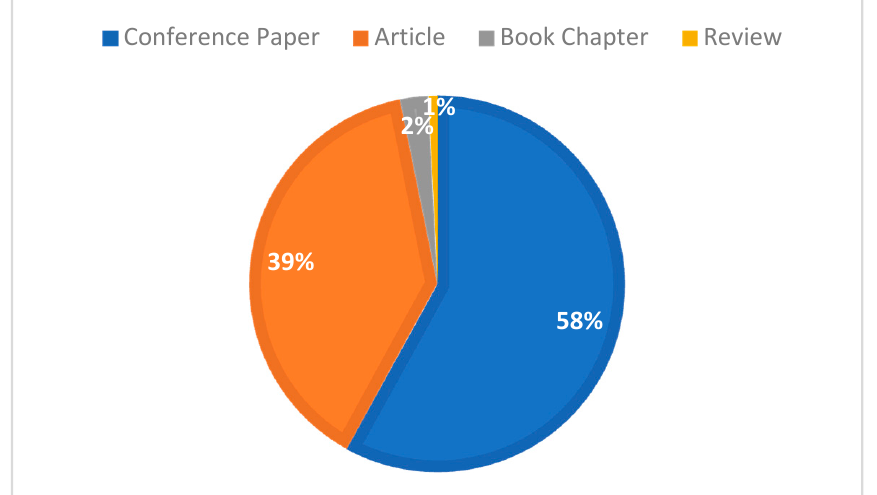
Figure 5. Proportion of the four main document types.